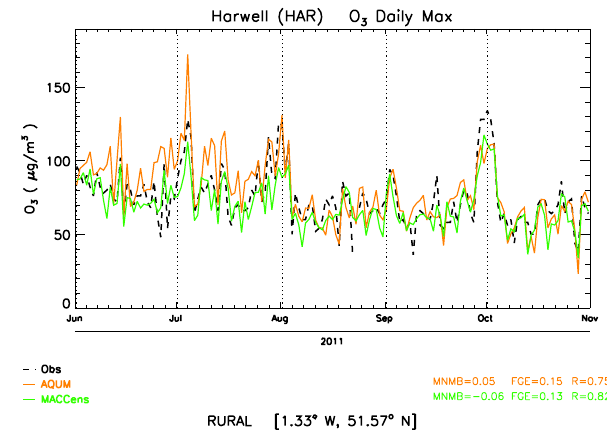
Fig. 17. AQUM and MACC ensemble predictions of daily maxi- mum ozone concentrations compared to observations at the rural site Harwell for 1 June to 31 October 2011. The observations are the black dashed line, AQUM output in orange and MACC ensem- ble predictions in